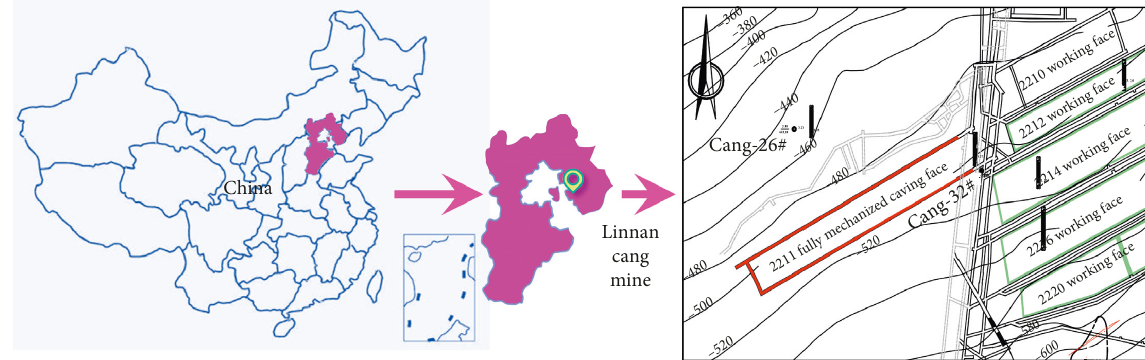
Figure 1: Layout of 2211 fully mechanized top coal caving face.